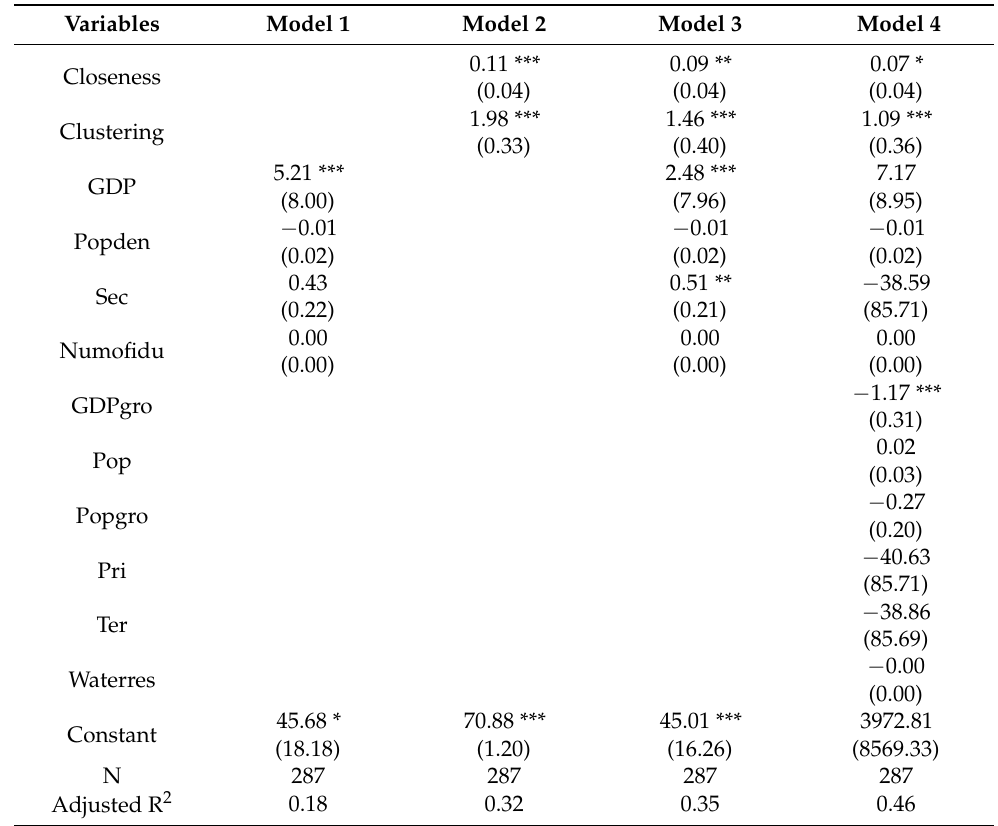
Table 3. Regression results for the influence of the local collaboration network on watershed manage- ment